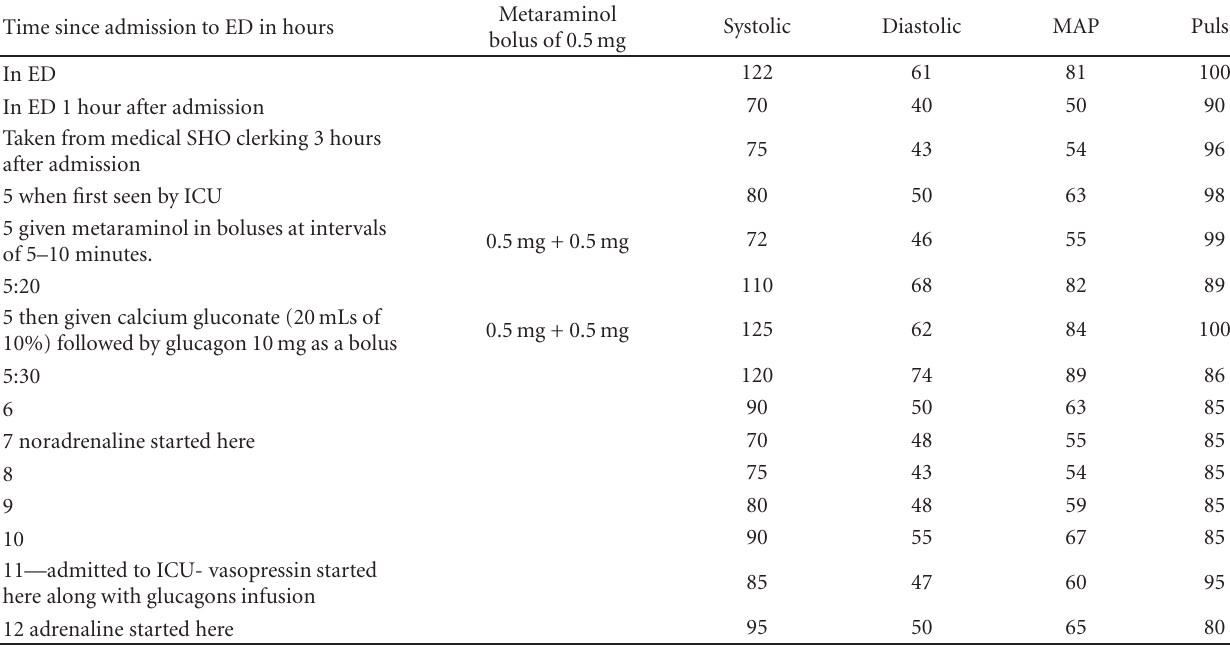
Table 1: Initial e ff ect of metaraminol boluses.